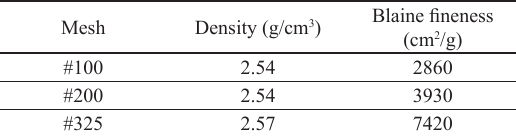
Table 3. Glass powder densities and Blaine fineness.